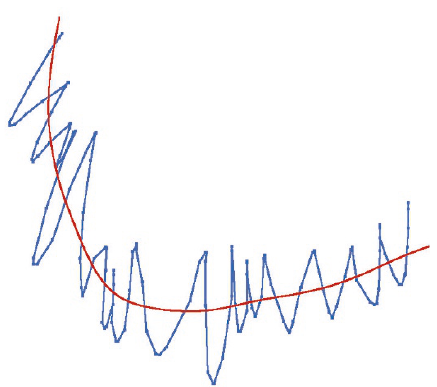
Figure 10: Illustration of an opened contour smoothing using an antimirror with pivot point extension. A hand-drawn line and its smoothed version are